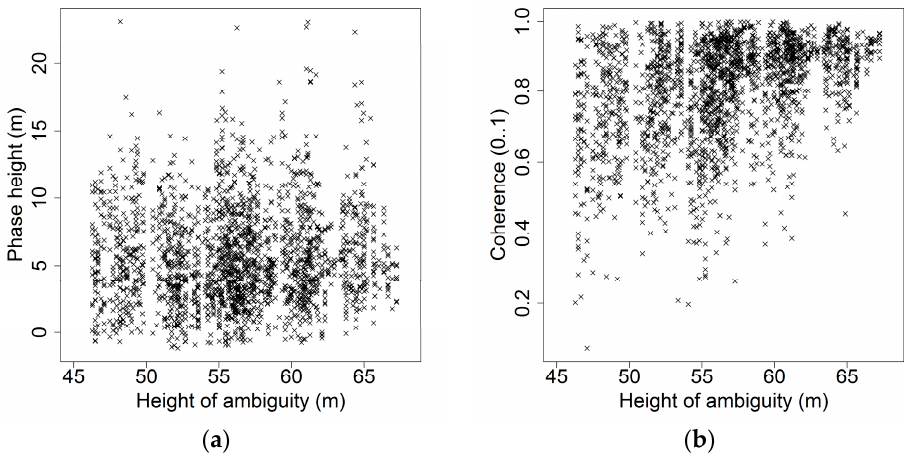
Figure 15. ( a ) Phase height ( φ ) vs. HOA. ( b ) Corrected coherence ( γ ) vs. HOA.